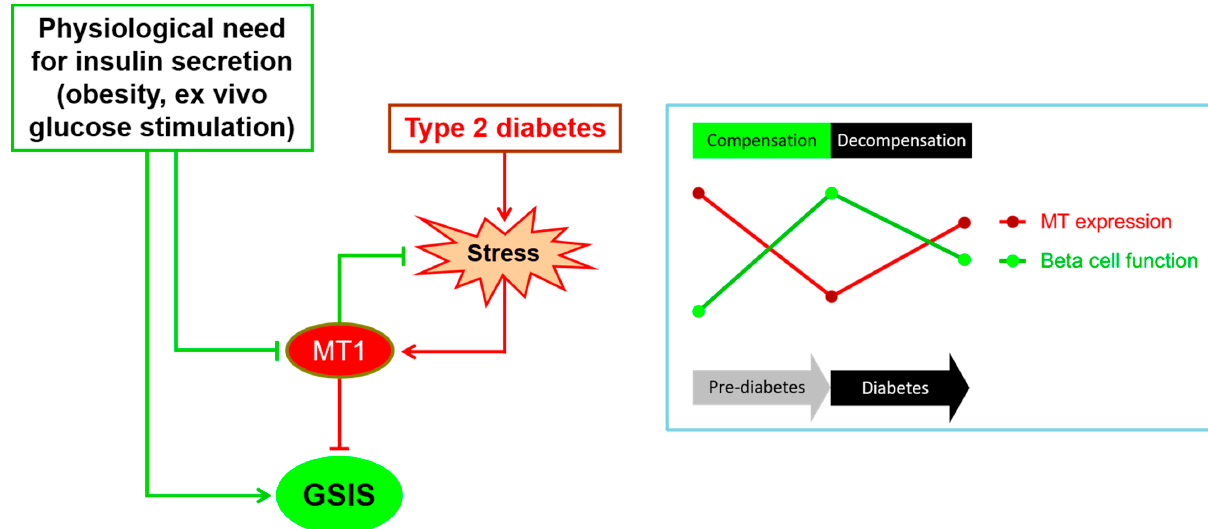
Figure 4. The proposed model of the role of MT1 in the pathogenesis of type 2 diabetes. Under physiological conditions requiring the stimulation of insulin secretion, Mt1 gene expression is repressed, thereby allowing enhanced secretory response to meet the metabolic needs. In contrast, under diabetes conditions, the unfavorable diabetic environment and subsequent induction of oxidative stress and other stress pathways lead to the upregulation of Mt1 gene expression. The latter is a double-edged sword that will, on one hand, counter beta-cell stress, at least in part through scavenging of ROS, and on the other hand, inhibit GSIS. These events occur sequentially during the natural history of diabetes, as depicted in the insert. In the prediabetic phase (beta-cell compensation), the beta-cell function is markedly enhanced in parallel with significant downregulation of MT gene expression. Conversely, in the diabetic phase (beta-cell decompensation), beta-cell function declines in parallel with significant upregulation of MT gene expression. GSIS: glucose-stimulated insulin